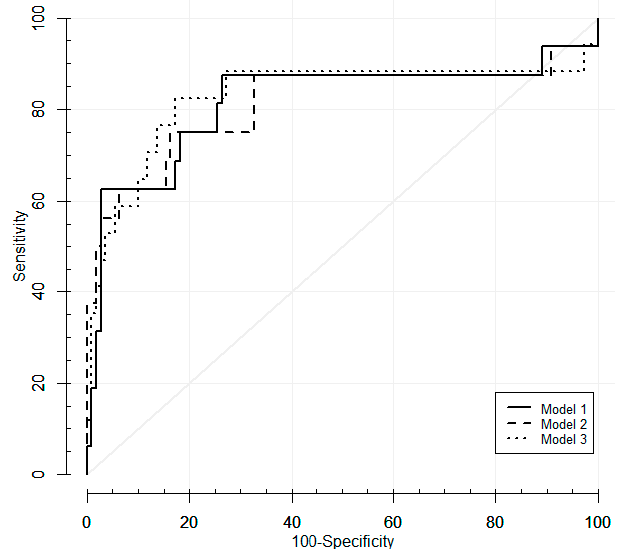
Figure 2. ROC curves of the cross-validated predicted probabilities of the three models for the prediction of malignancy in cytological negative lymph nodes.